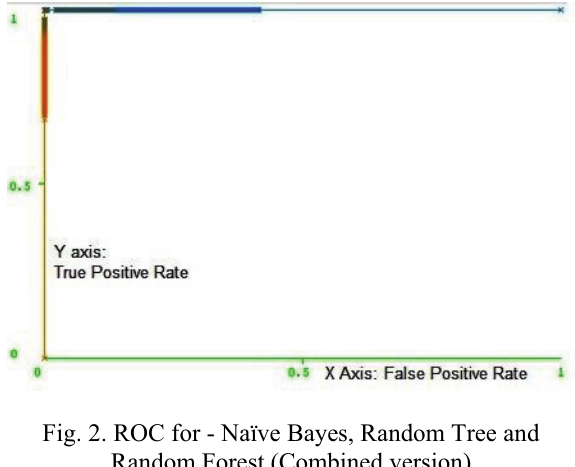
Table 3. Performance of Filter Method Naïve Bayes and Wrapper Method Naïve Bayes (Cross Validation of 10 Cross Folds)